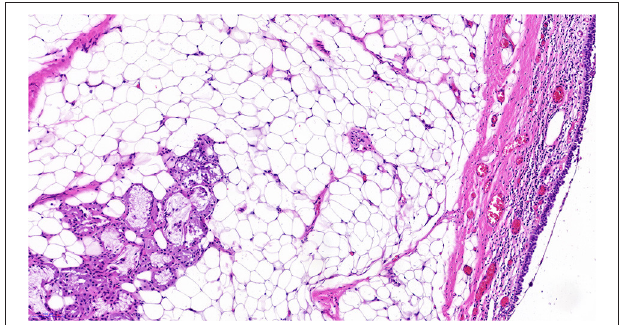
FIGURE 3 | The tumor was a hamartoma largely comprising mature fat cells.